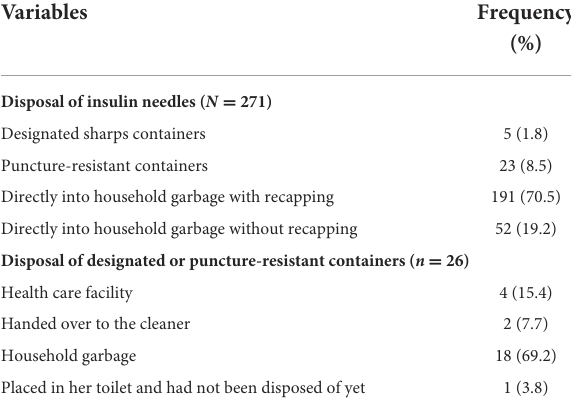
TABLE 2 Participants’ disposal practices of insulin needles.